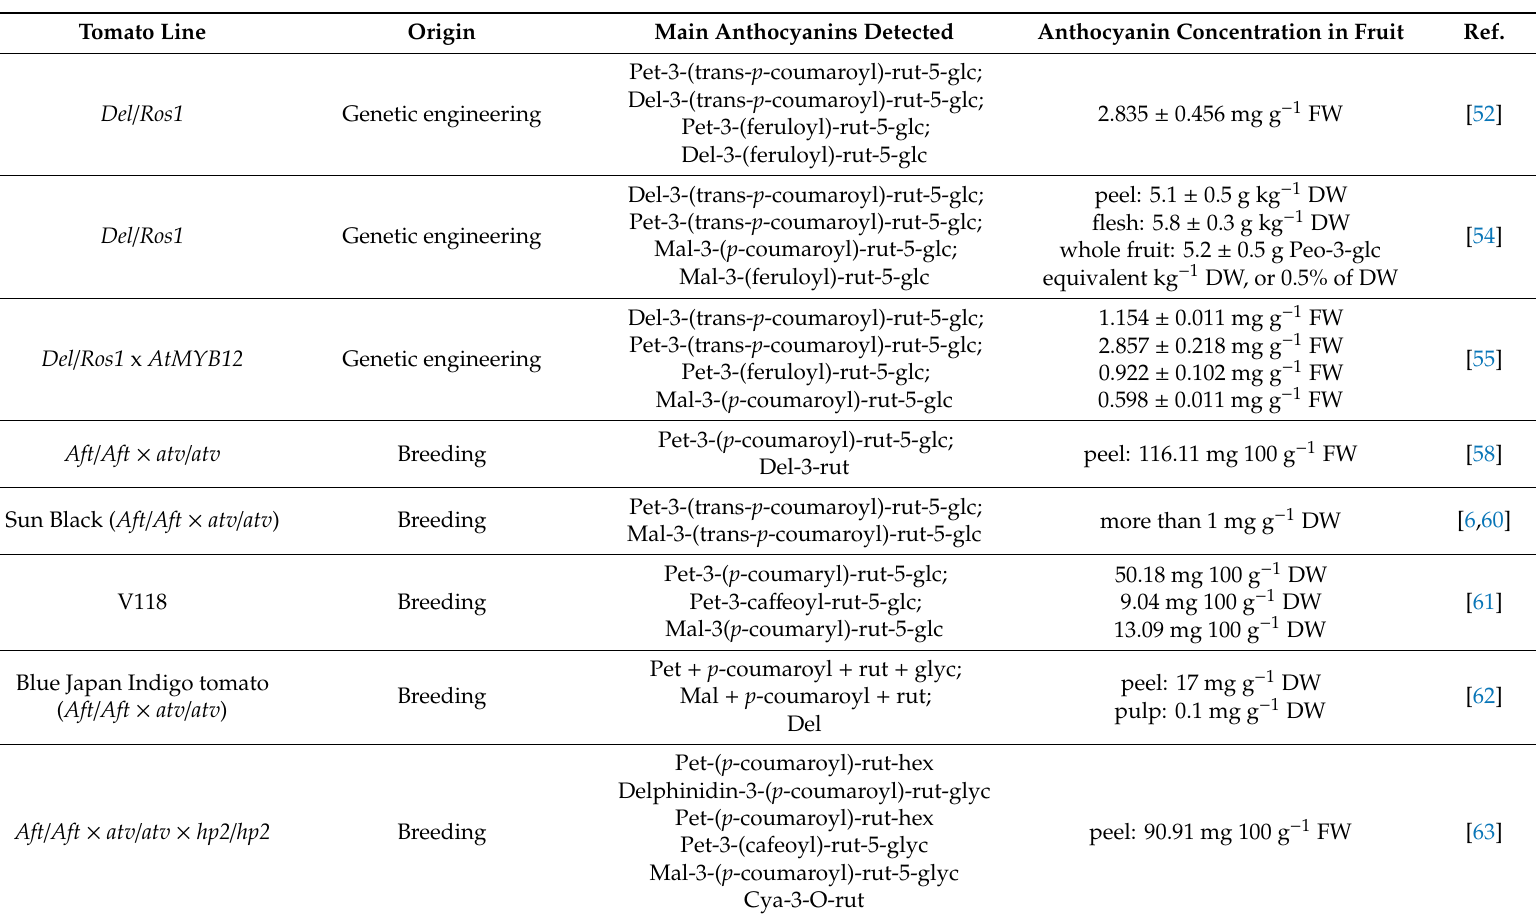
Table 2. Main purple tomato lines obtained through genetic engineering or breeding programs and relative anthocyanin content and composition. Abbreviations: